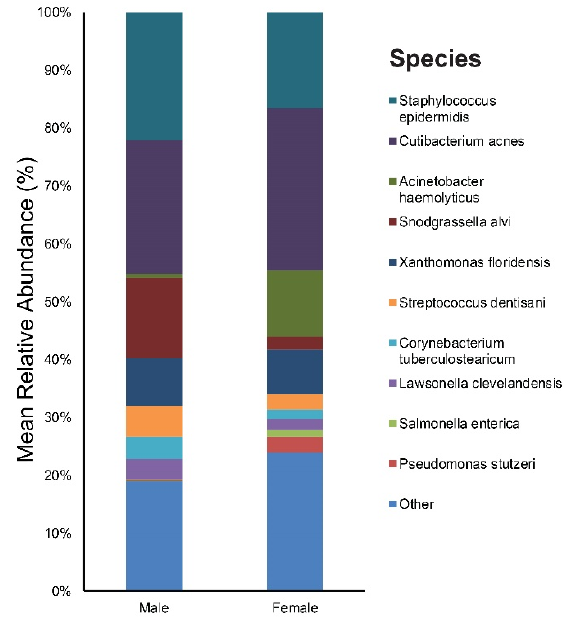
Figure 6. Bar graph on baseline skin microbiota according to sex (male and female).